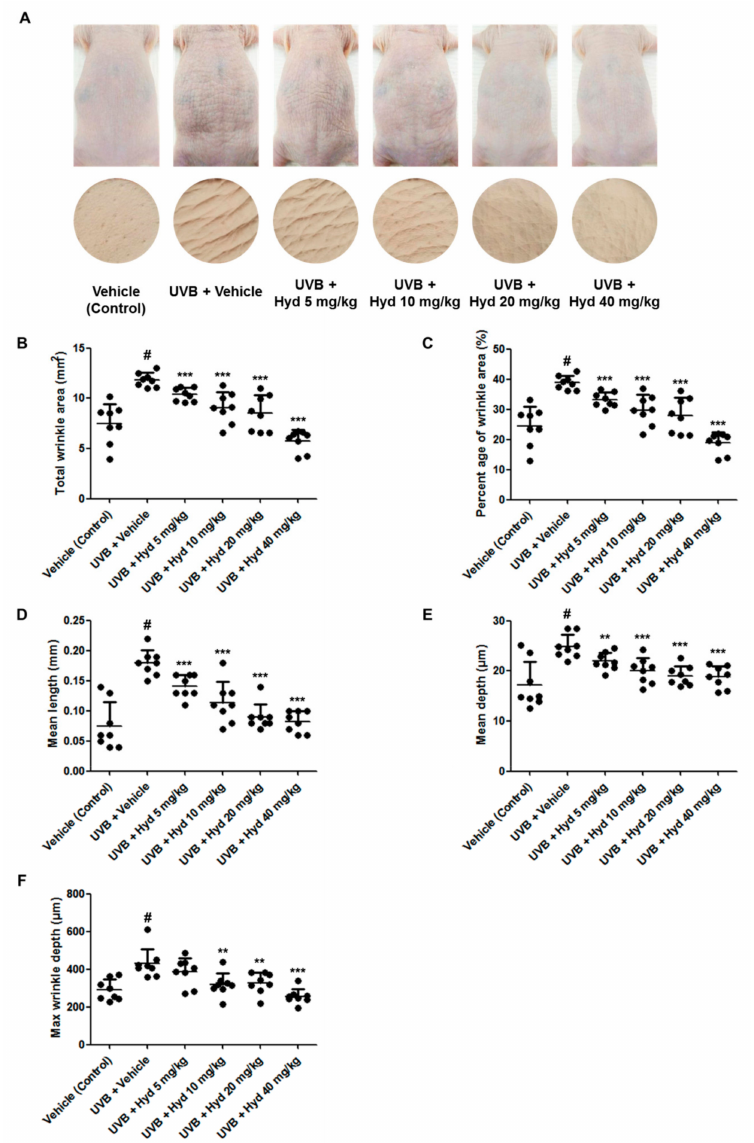
Figure 2. E ff ects of oral administration of hydrangenol on UVB-induced wrinkles in hairless mice. HR-1 hairless mice were administered hydrangenol (5, 10, 20, or 40 mg / kg) daily for 7 weeks of exposure to ultraviolet B (UVB). ( A ) Representative images of dorsal skin surface and replicas exposed to UVB. ( B – F ) The parameters for wrinkle formation, including ( B , C ) total wrinkle area, ( D ) mean length, ( E ) mean depth, and ( F ) max wrinkle depth, were obtained from the skin replica analysis. Values are expressed as means ± SD ( n = 8). # p < 0.05 vs. the vehicle-treated control group; ** p < 0.01, and *** p < 0.001 as compared to the UVB + vehicle-treated